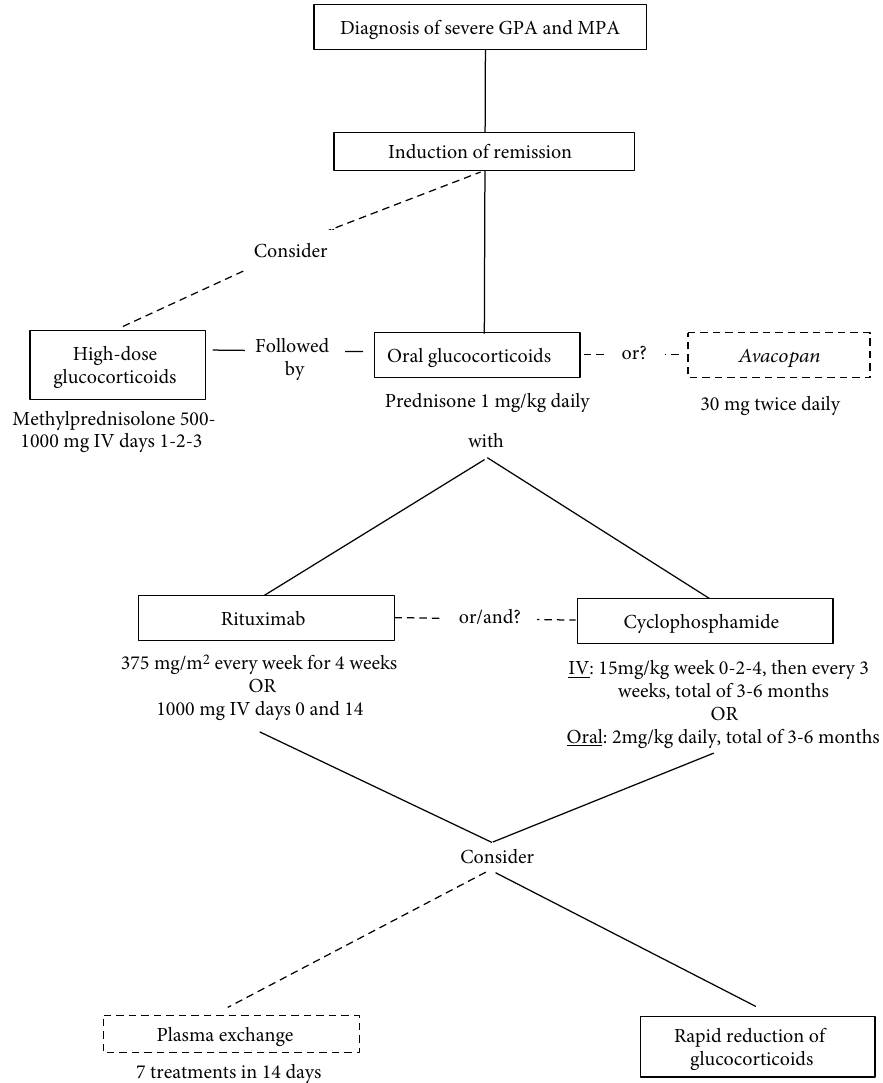
Figure 2: Suggested algorithm of induction therapy in severe GPA or